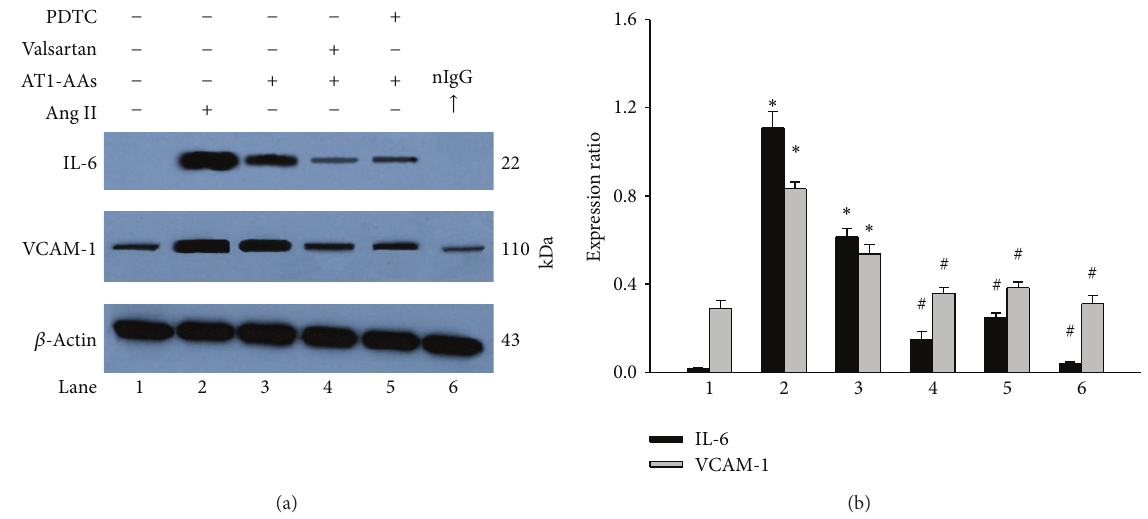
Figure 5: Effects of valsartan and PDTC on AT1-AAs or angiotensin II-induced protein expression in human endothelial cells. Valsartan (AT1 receptor blocker) and PDTC (NF- 𝜅 B inhibitor) were added to cell medium 2 hours before AT1-AAs treatment for 12 hours. Panel (a) shows the typical Western blot results. Panel (b) shows the summarized data ( 𝑛 = 5 ); ∗ 𝑃 < 0.05 versus control group (lane 1); # 𝑃 < 0.05 versus AT1-AAs group (lane